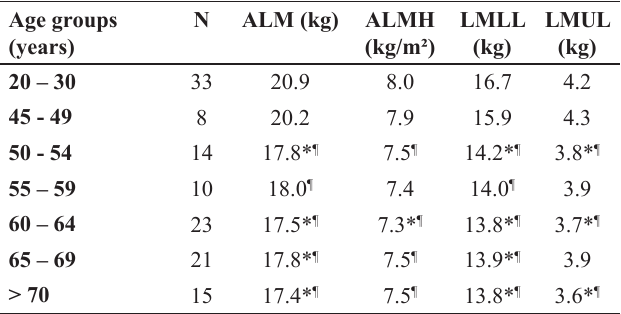
Table 2. Mean values of ALM, ALMH, LMLL, and LMUL in different age groups - control group aged 20 to 30 years and study group over 45